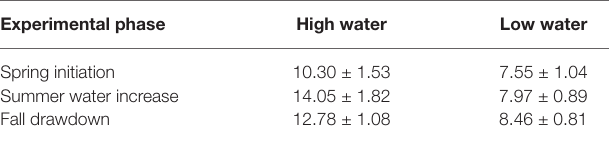
TABLE 1 | Average soil water content (%) measurements of the two watering regimes during three phases of the